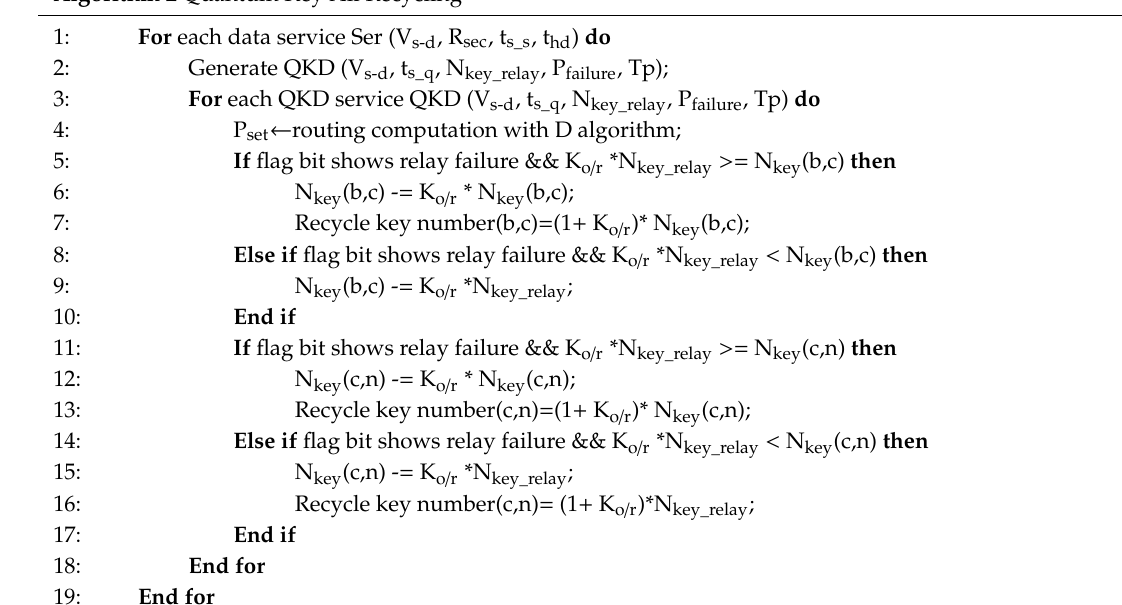
Algorithm 2 Quantum Key All